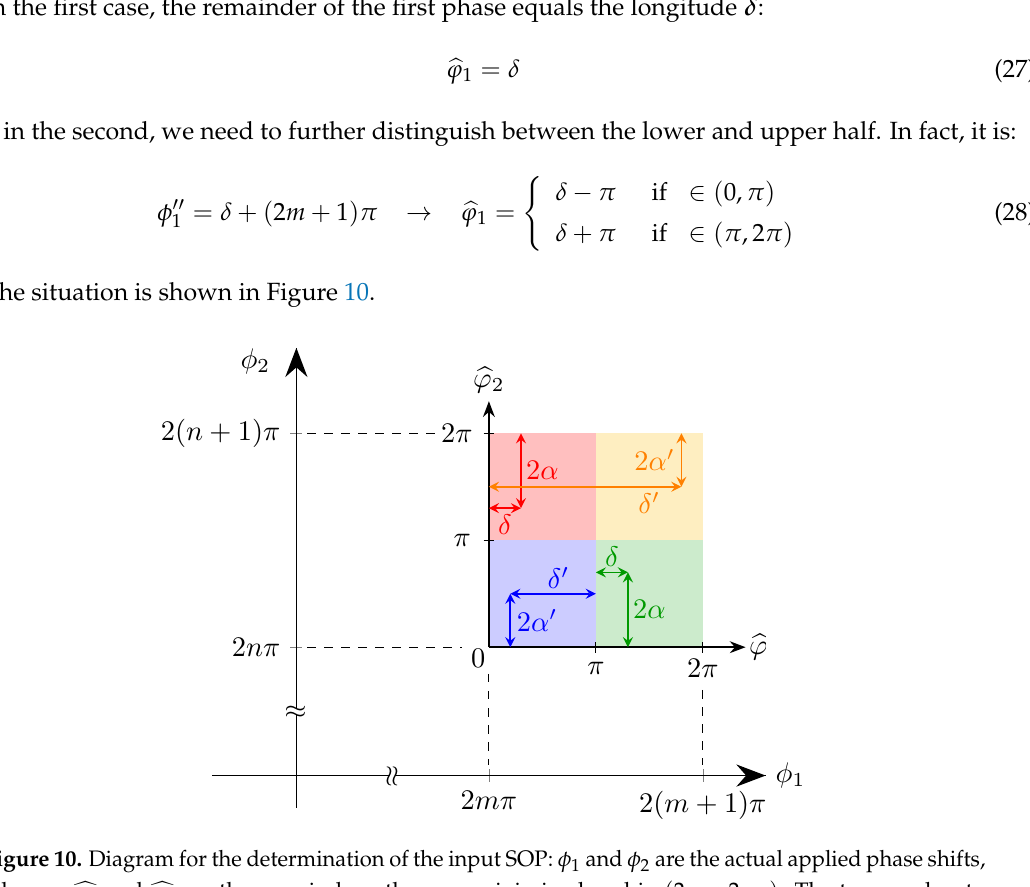
) , while the lower ones (blue and , φ (cid:48) 2 1 ( 0, π ) , whilst the yellow and blue ones to ∈